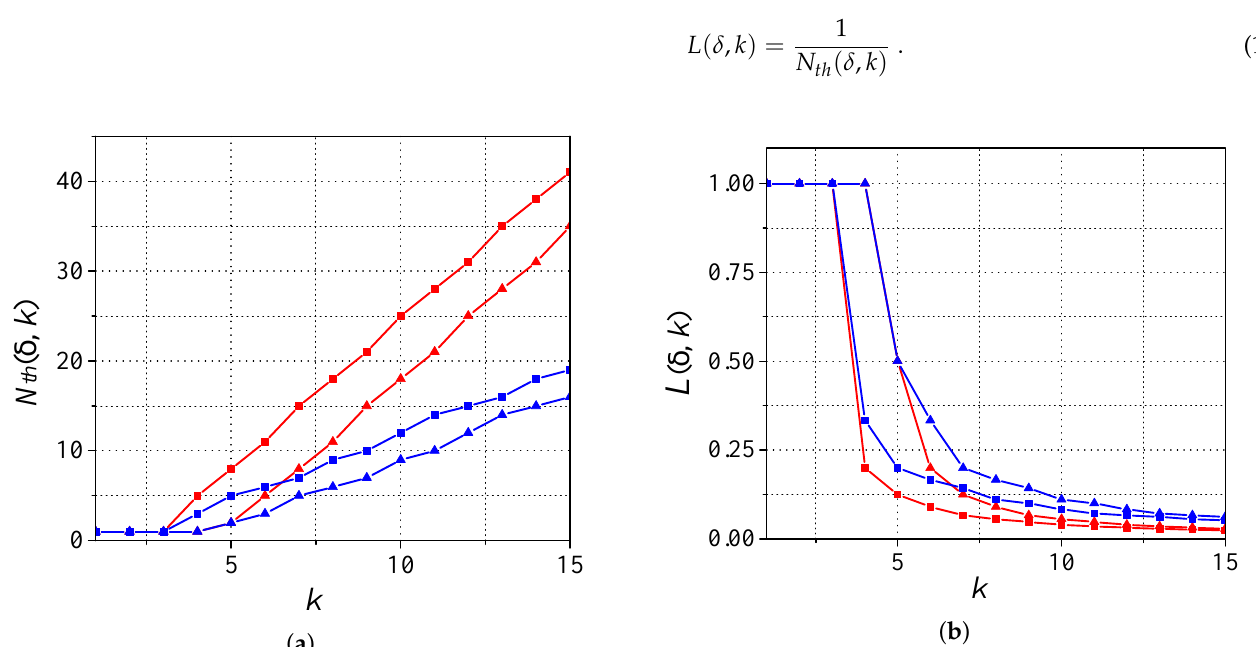
Figure 8. Sensitivity to initial conditions for the FC and the STM, ( a ) N th ( δ , k ) and ( b ) L ( δ , k ) versus k , considering k ∈ [1, 15], x 0 = 0.1, µ = 1.0, α = 2.0, and n = 1000 with δ = 1 × 10 − 3 (“ (cid:4) ") and δ = 1 × 10 − 5 (“ (cid:78)